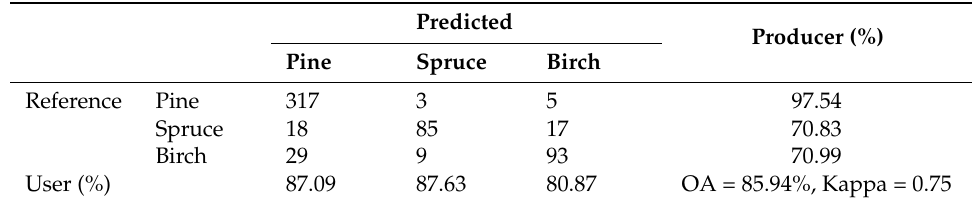
Table 7. Confusion matrix and accuracy evaluation of classification with 15 selected point cloud and single-channel intensity feature combination and test data.